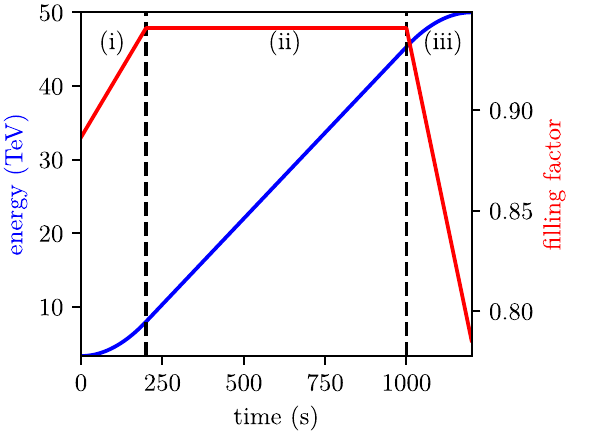
FIG. 10. The energy program and evolution of the filling factor during the ramp in the FCC-hh: (i) the parabolic, (ii) linear, and (iii) parabolic parts of the energy program.